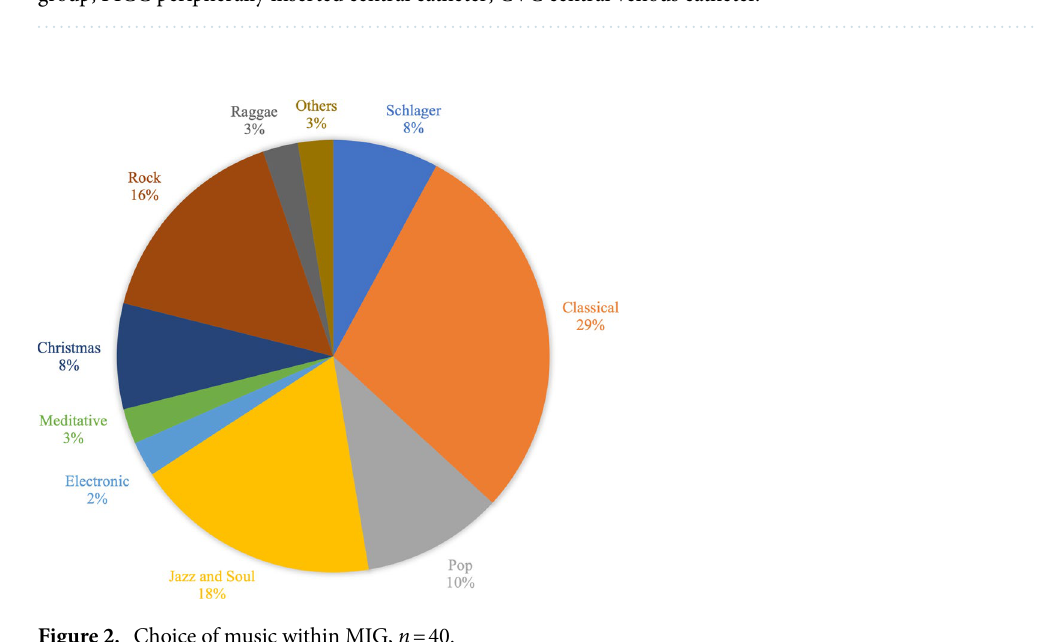
Table 1. Comparison of baseline characteristics among the two study groups. a Independent samples test (MIG vs. CTRL). b Chi-Square Test, confidence interval 95% CTRL control group; MIG music intervention group; PICC peripherally inserted central catheter; CVC central venous catheter.